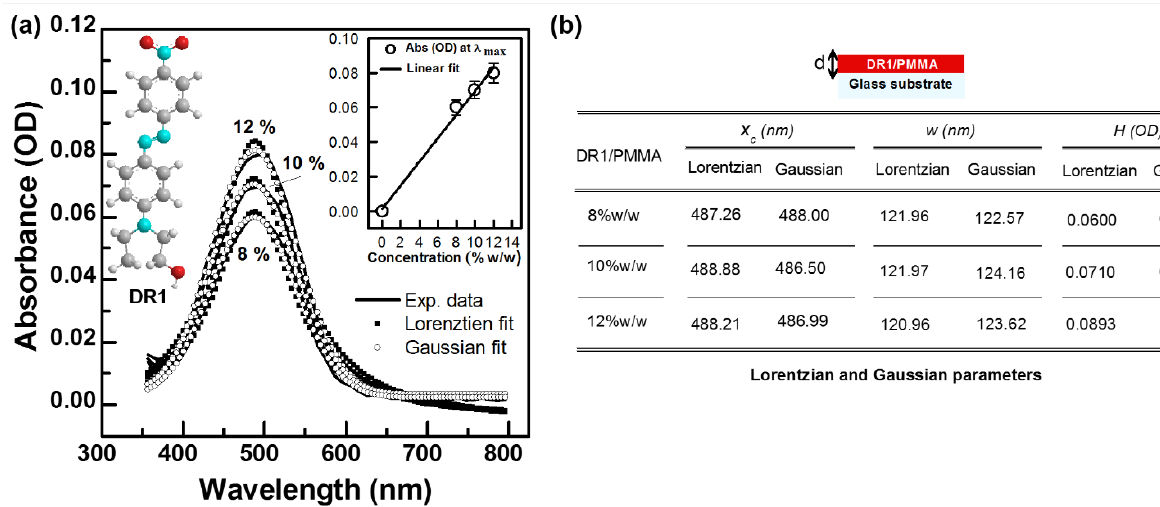
Figure 1. ( a ) Absorption spectra of DR1/PMMA thin films with different weight concentrations of DR1 versus PMMA C (% w / w ). The inset shows a linear evolution of the maximum of absorption, at 𝜆 𝑚𝑎𝑥𝐷𝑅1 = 488 nm of the film, with its concentration, for a fixed film thickness d ∼ 58 nm; and the absorbance extrapolate to the origin. The solid curves are the experimental data, and the close circles’ curve is a Lorentzian theoretical fit 𝑦 = 𝑦 0 + (2𝐴 𝜋⁄ )(𝑤 (4(𝑥 − 𝑥 𝑐 ) 2 + 𝑤 2 )⁄ , while the open circles’ curve is Gaussian theoretical fit 𝑦 = 𝑦 0 + 𝐴𝑒 −𝑙𝑛(2) (𝑥−𝑥 𝑐 ) 2 𝑤 2 ⁄ 𝑤⁄ √𝜋 4𝑙𝑛 (2)⁄ , where 𝑦 0 is the baseline. ( b ) The values of the characteristic parameters of the Lorentzian and Gaussian are given in the table. The Lorentzian function does not fit the data as well as the Gaussian function at the infrared tail ~ 700 nm.